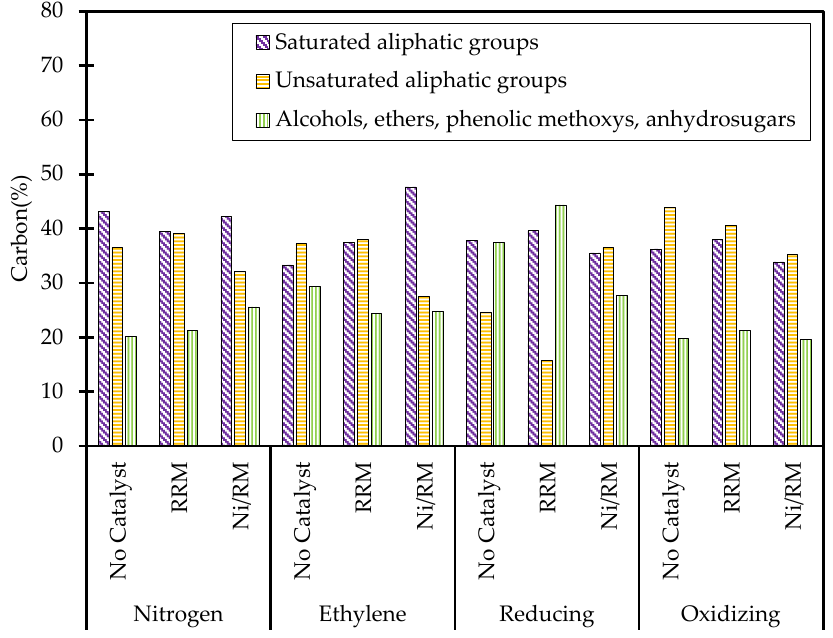
Figure 5. Functional group distribution in 13 C NMR analysis of Tetraselmis biocrudes.